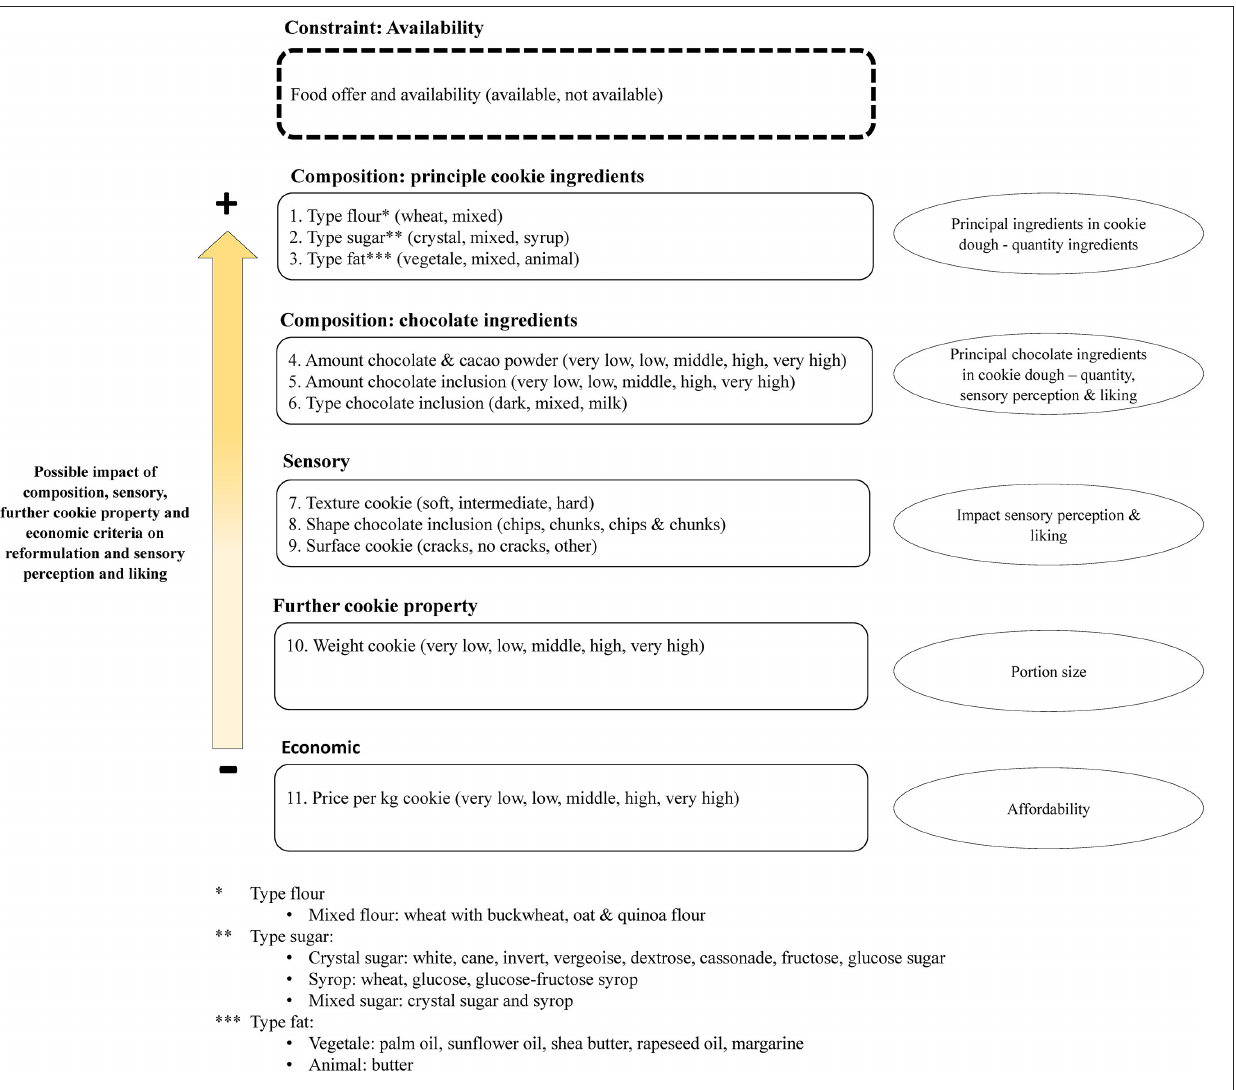
FIGURE 2 | Overview of the 11 additional ranked criteria with their 40 subgroups (in brackets) and the availability as